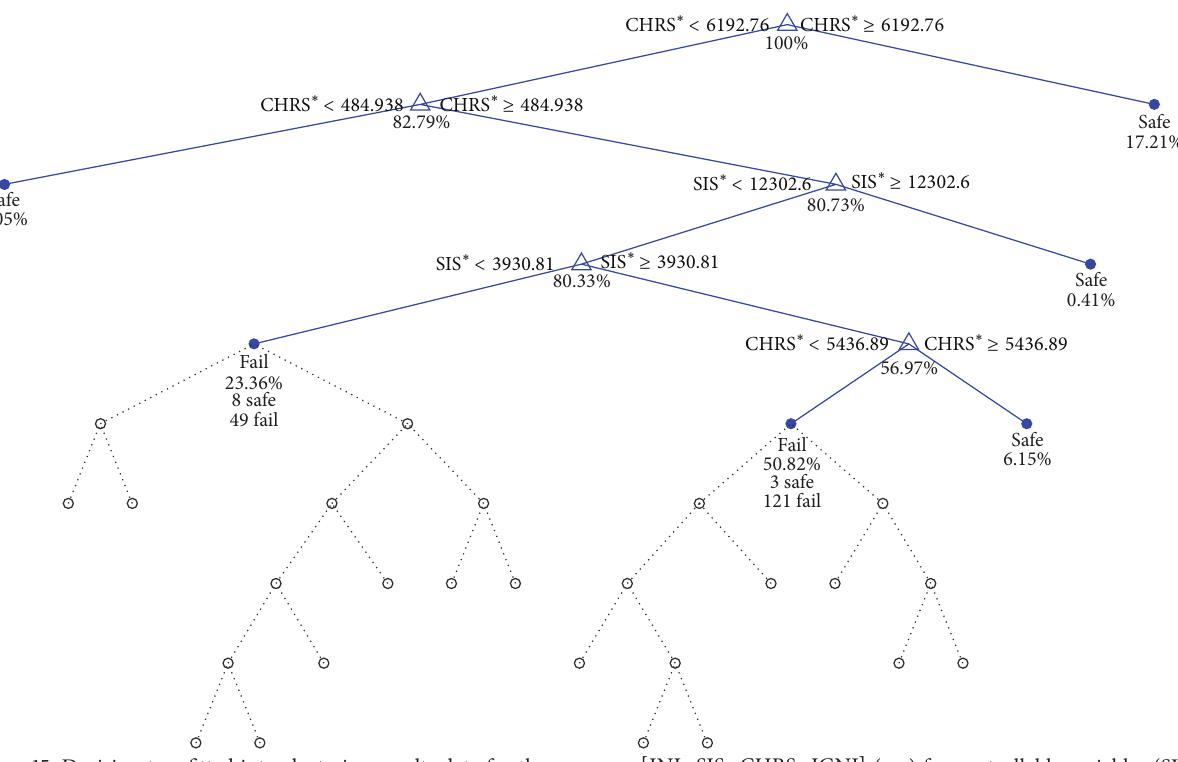
Figure 15: Decision tree fitted into clustering results data for the sequence [ INI SIS CHRS IGNI ] (sec) for controllable variables (SIS ∗ , CHRS ∗ : in coordinate system defined by principal components of the